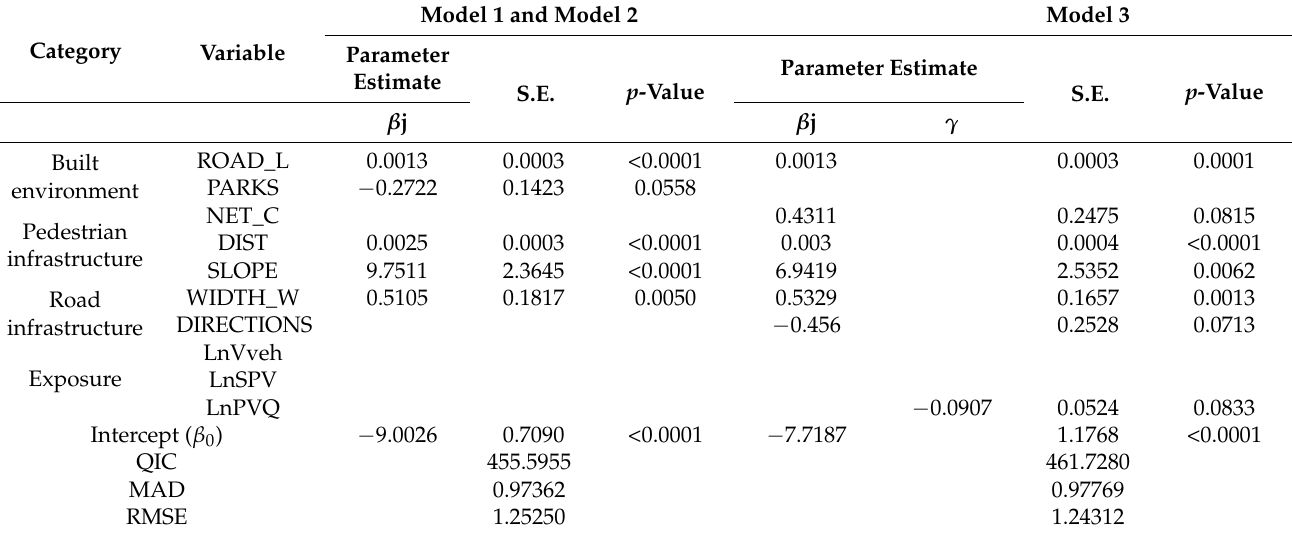
Table 4. GEE models—disaggregated crash data (Models 1, 2 and